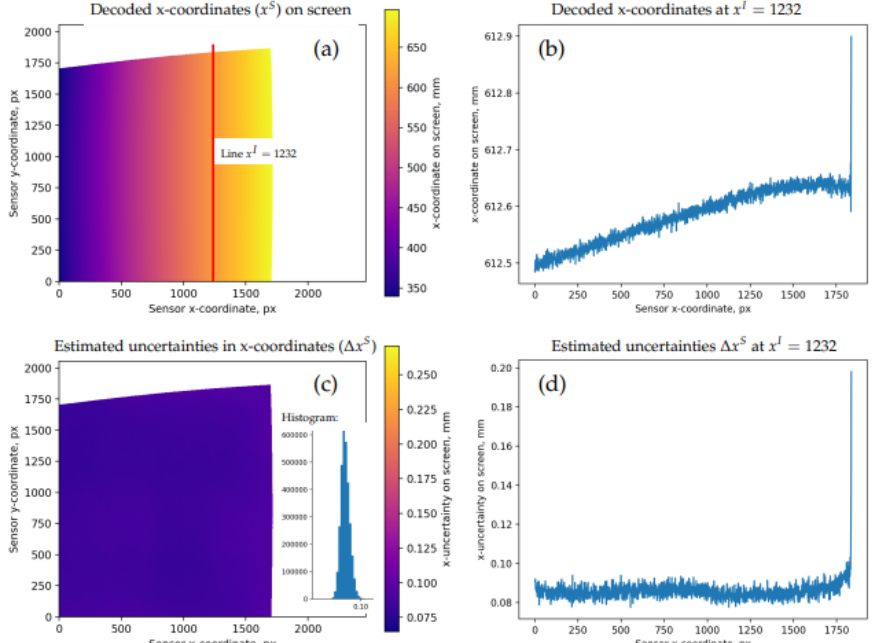
Figure 3. Sample data frame (dataset 4, pose 17). ( a ): map of the decoded x S (x-coordinates on the screen); ( b ): profile of x S along the line x I = 1232 (indicated with a red line in ( a ); note that x I and y I refer to pixel coordinates in the recorded images); ( c ): estimated decoding uncertainties ∆ x S and their histogram (number of pixels vs ∆ x S ); ( d ): profile of ∆ x S along the line x I = 1232. Similar maps are also available for y S (decoded y-coordinates on the